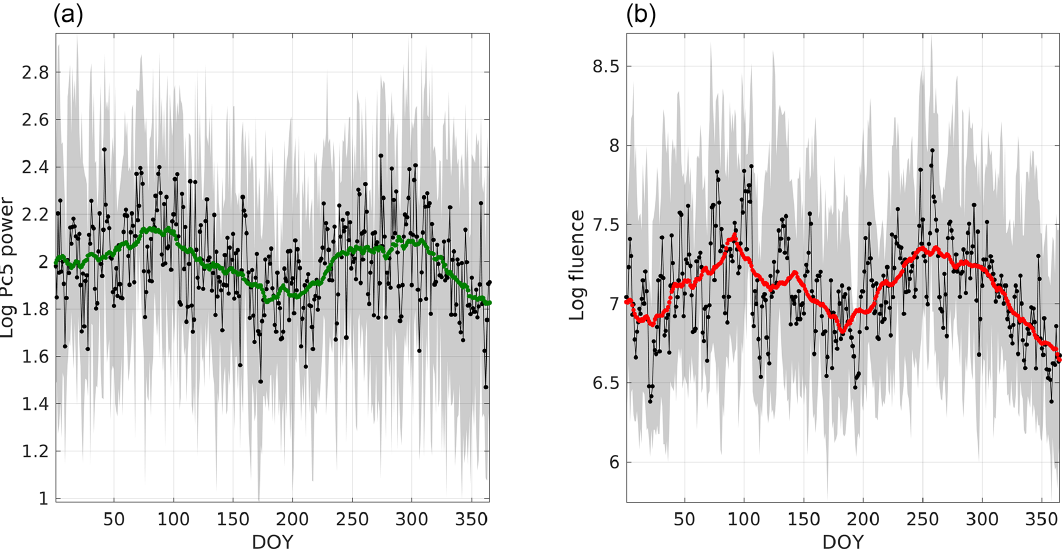
Figure 6. Superposed epoch analysis of the logarithmic values of Pc5 power (a) and fluence (b) . The median and quartiles are illustrated as a black curve, lower limit and upper limit of the gray band, respectively. The zero epoch is the first day of year (DOY), and the green and red curve are the 30d running average of the median curve (Pc5 SAV and Fl SAV ).